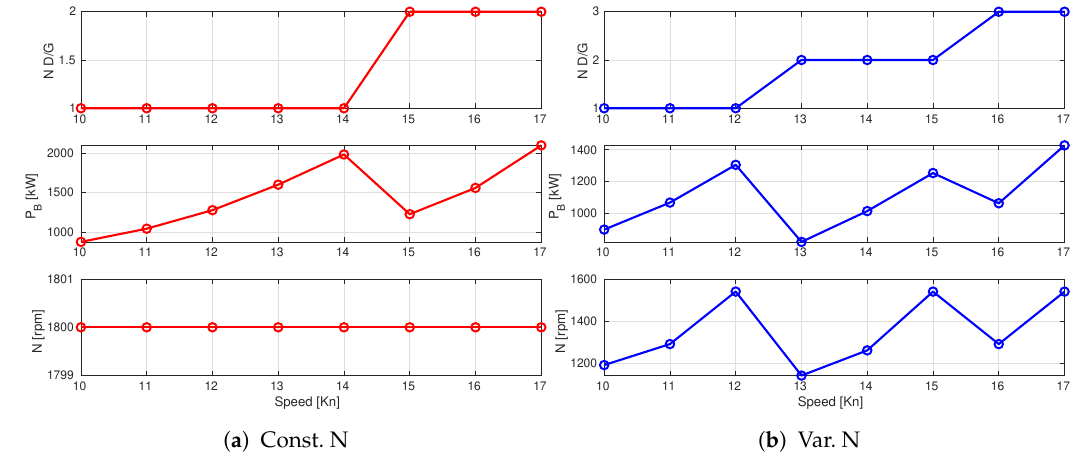
Figure 5. Off-design optimal propulsion configurations, number of D/G, revolution speed and power: constant ( a ) and variable D/G revolution speed propulsion plant ( b ).